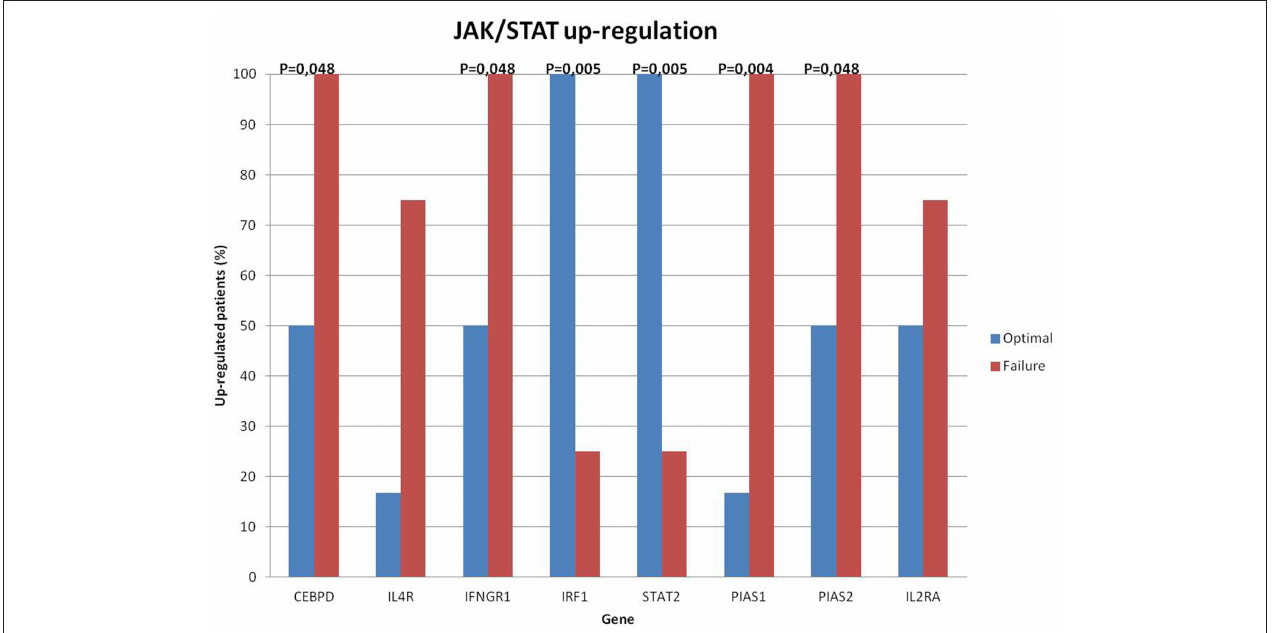
FIGURE 1 | JAK/STAT significantly de-regulated genes. Optimal responders in blue columns and failing patients in red. Up-regulation of some JAK/STAT genes was significantly correlated to patients clinical response ( p ≤ 0.05).